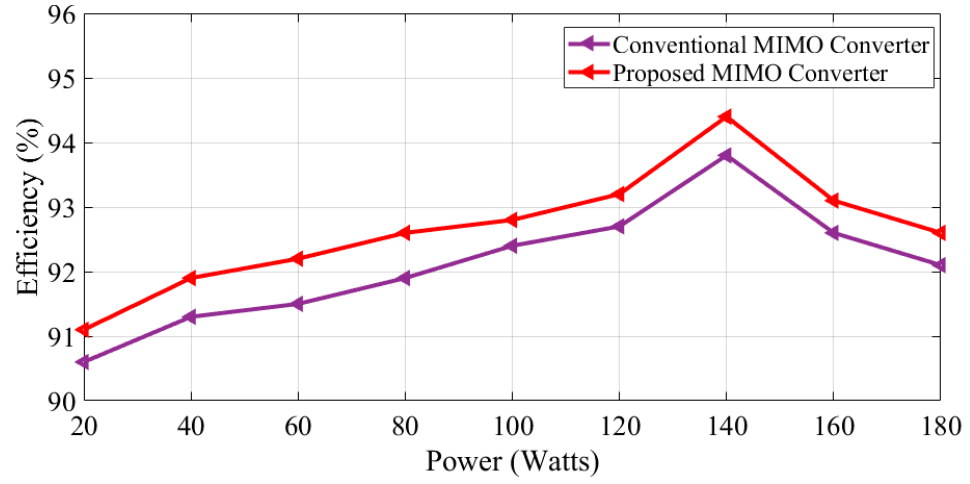
Figure 21. Power versus efficiency graph.